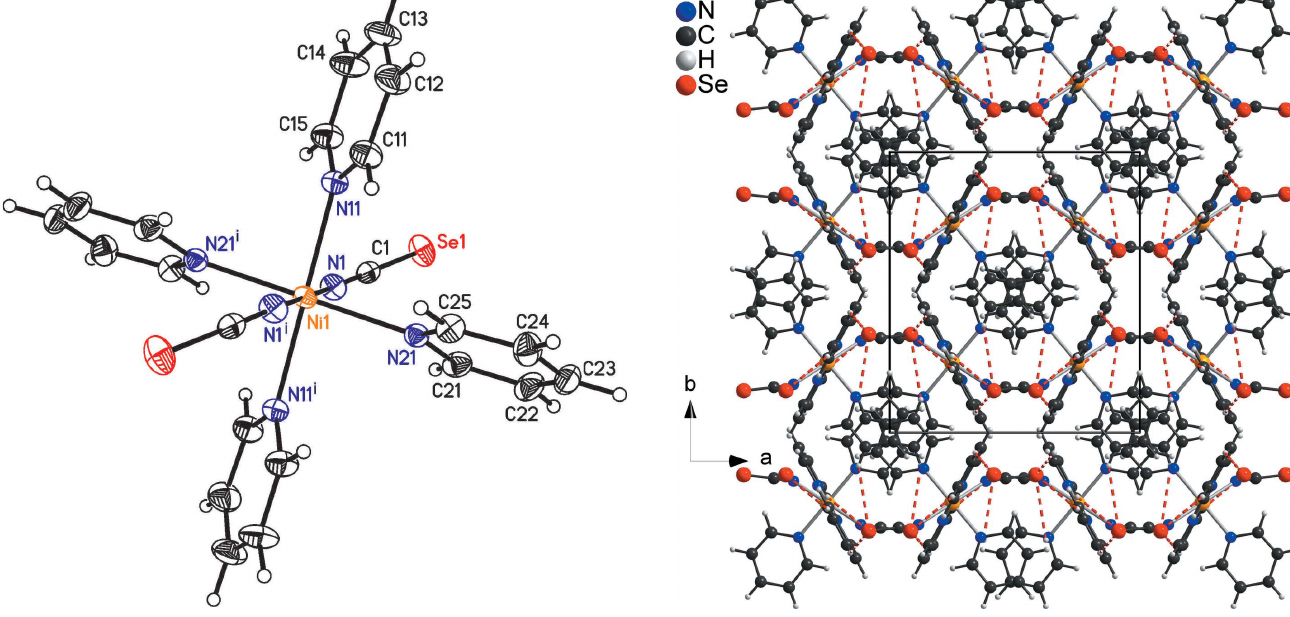
Figure 4 Crystal structure of the title compound with view along the crystal- , 2